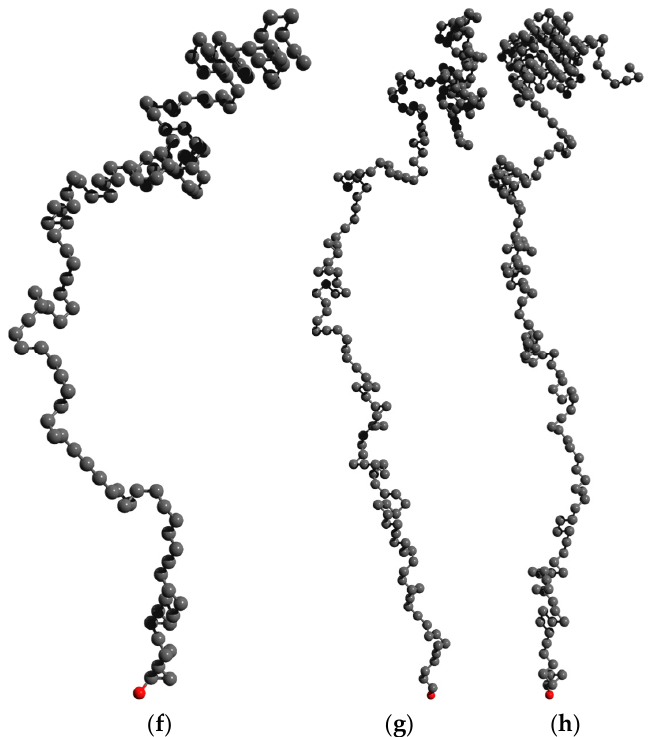
Figure 7. Typical chain conformations in the system with DP n = 160: m = 90 ( a ), m = 130 ( b ), m = 180 ( c ), and m = 230 ( d ). Enlarged typical single-chain conformations are also presented: ( e ) for ( a ), ( f ) for ( b ), ( g ) for ( c ), and ( h ) for ( d ).